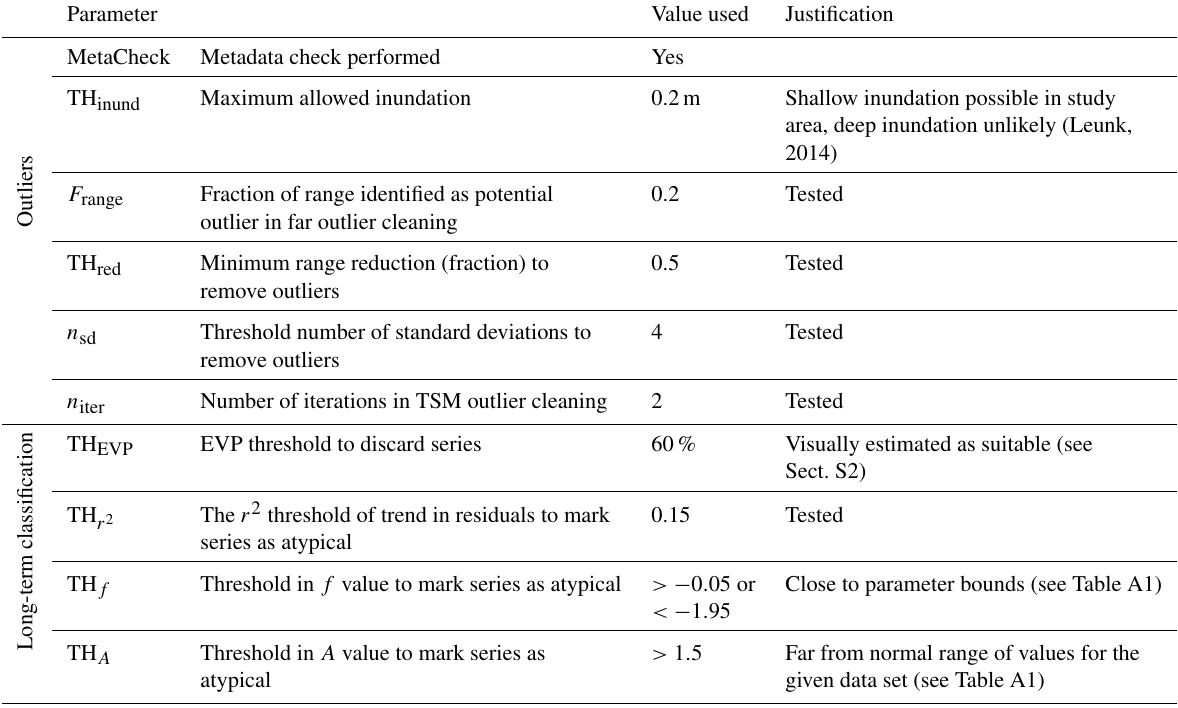
Table 1. Parameters used for the series validation. Parameter Value used Justification